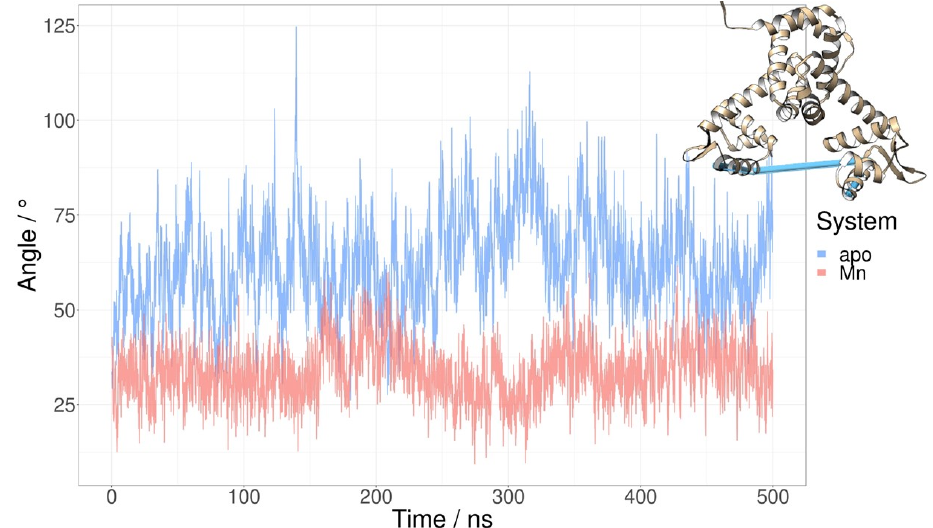
Figure 4. The dihedral angle between the DNA-binding helices for the MntR protein during the MD simulation of apo- (blue) and Mn 2+ -bound form (pink) of the protein. The dihedral angle is defined using the backbone C atoms of residues 47, 36, 189 and